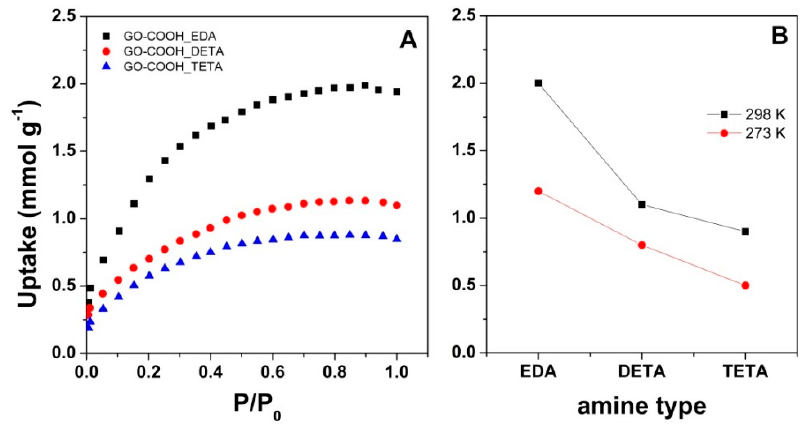
Figure 7. The CO 2 adsorption isotherm at 298 K ( A ) and evolution of CO 2 uptake with temperature ( B ) for the amine-modified cryogels.